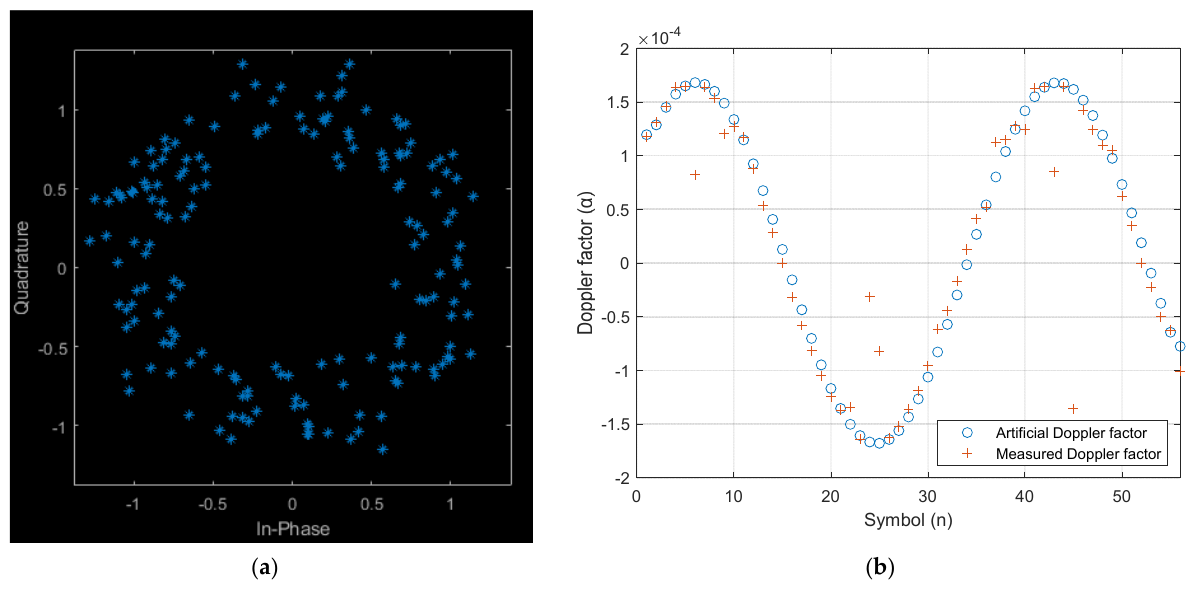
Figure 16. ( a ) Constellation diagram of DSSS. ( b ) Artificial Doppler factor and results of measured Doppler factor from the received data.